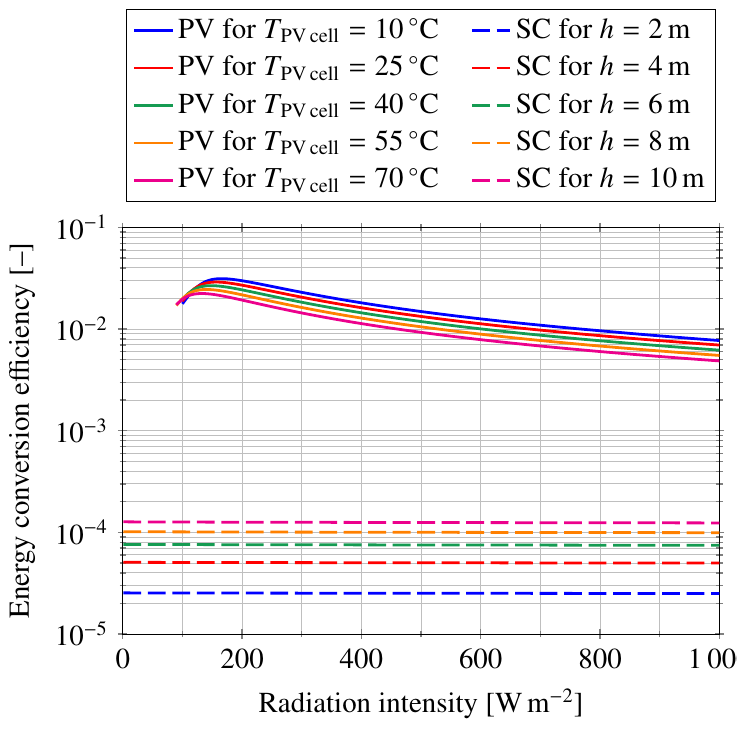
Figure 7. Energy conversion efficiency for the solar chimney and PV-powered